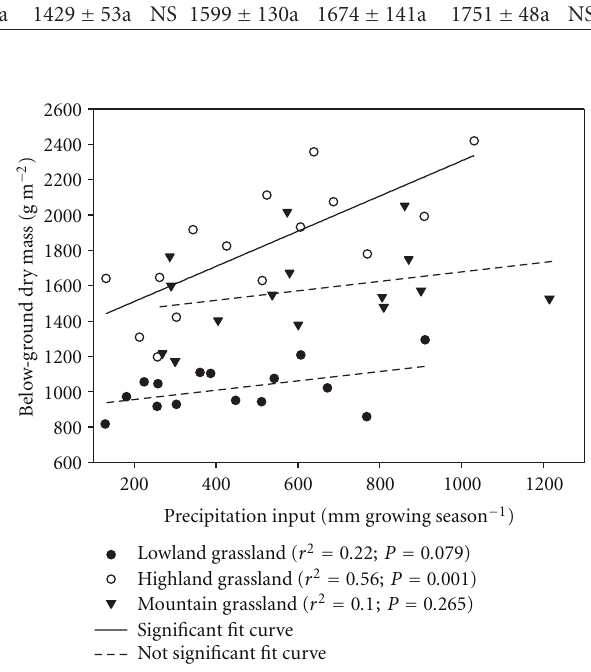
Highland grassland ( r 2 = 0 . 56; P = 0 . 001)